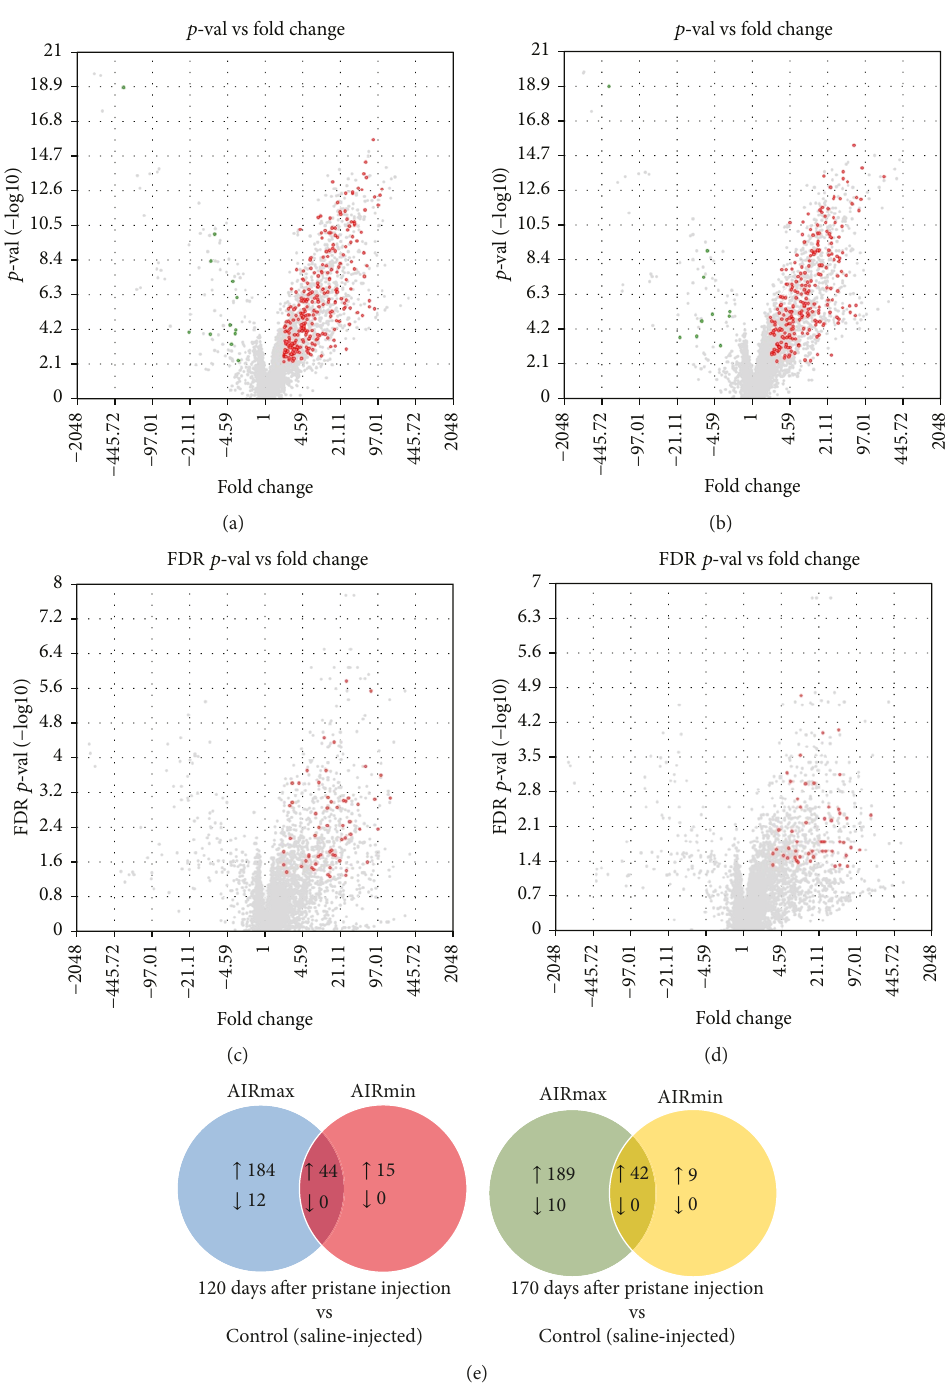
Figure 3: Upregulated (red) and downregulated (green) miRNAs after pristane injection in peritoneum. (a) AIRmax 120 days, (b) AIRmax 170 days, (c) AIRmin 120 days, (d) AIRmin 170 days, and (e) exclusives and commons miRDEGs in AIRmax and AIRmin lines injected with pristane and compared to controls. Di ff erentially expressed miRNAs (miRDEGs) were detected using unpaired one-way ANOVA in the Transcriptome Analysis Console 3.0 (TAC) software, with FDR < 0 05 considering a minimum di ff erence of 2 times for di ff erentially expressed genes. N = 5 animals per